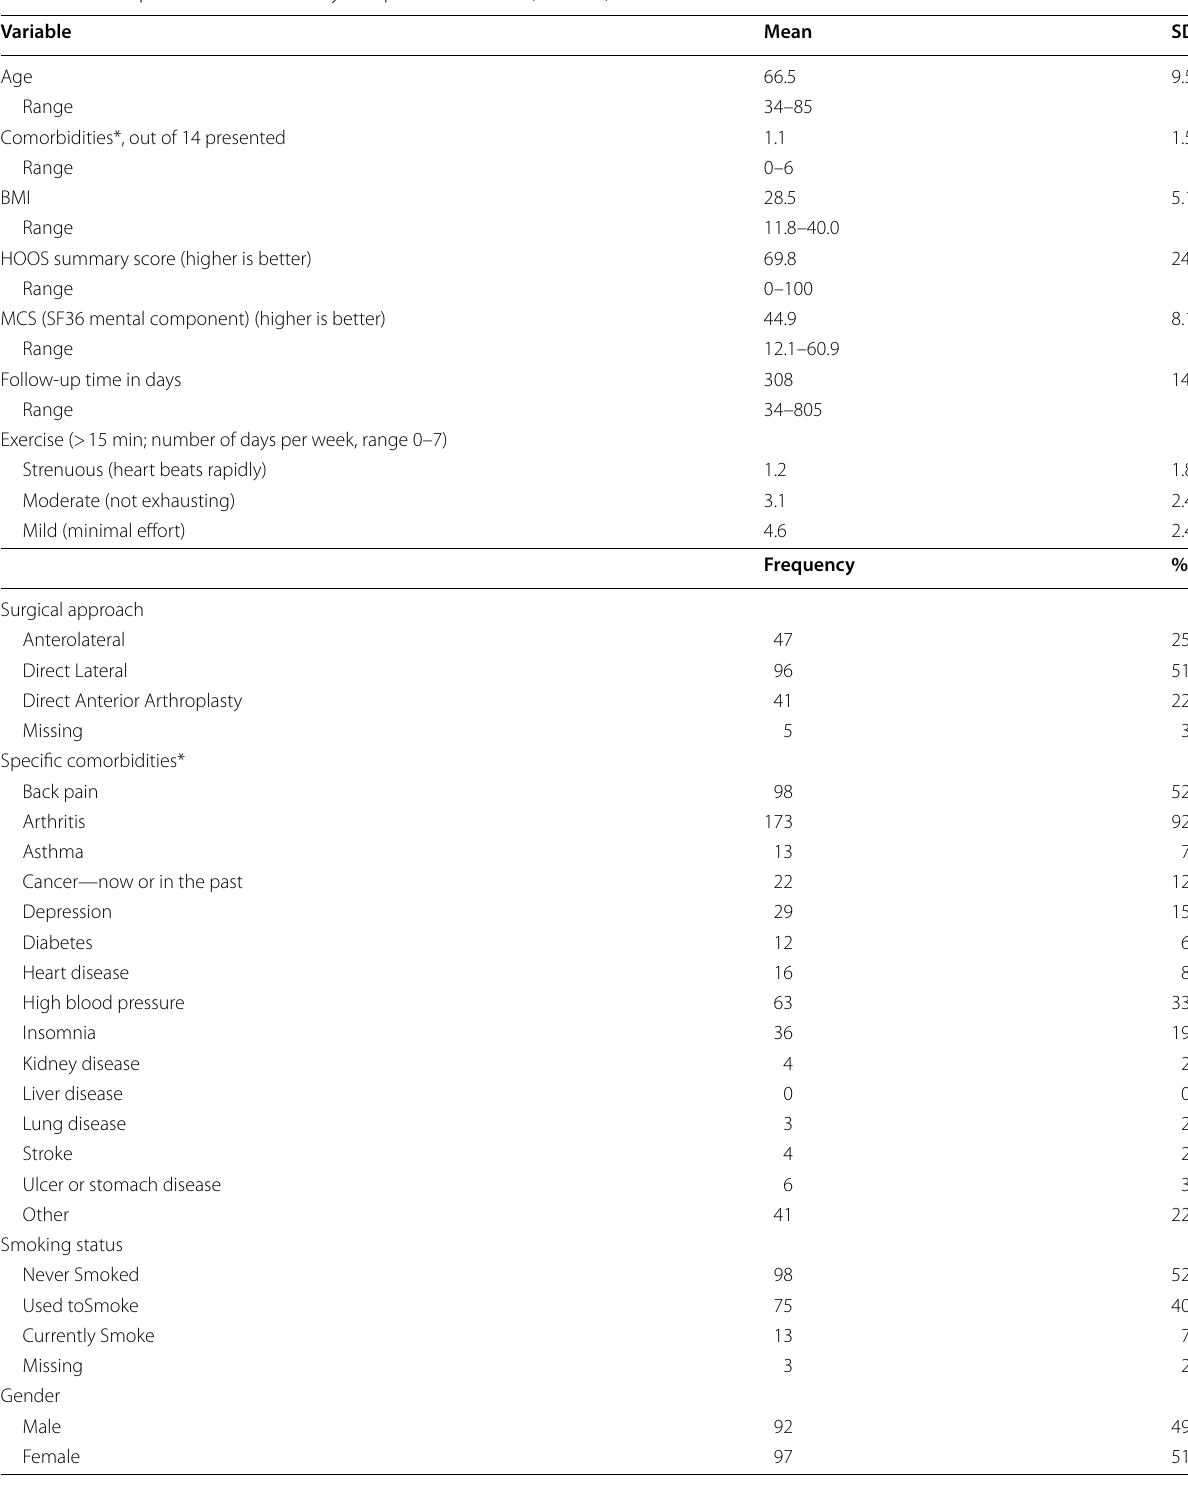
Table 1 Descriptive statistics of study sample at baseline† (N